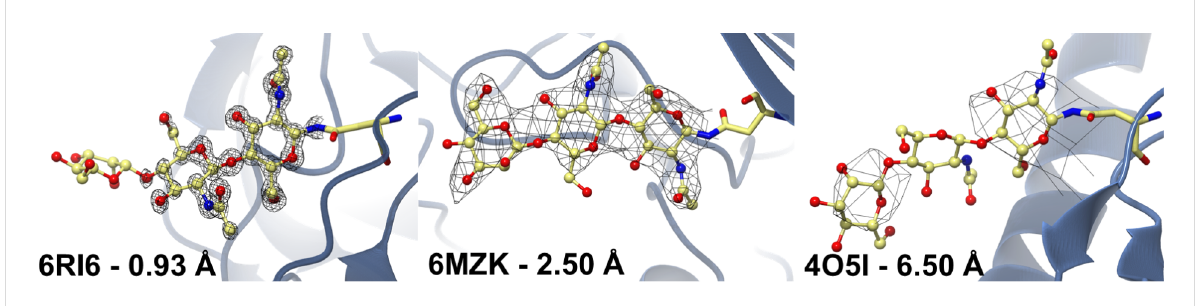
Figure 1: Comparison of the glycan features in electron density maps over a range of resolutions from selected glycoprotein structures (PDB entries: 6RI6 [19]; 6MZK [20]; 4O5I [21]). The electron density maps were obtained with X-ray crystallography. The data resolution and PDB entry IDs associ- ated with the structures have been directly annotated on the structure. Left: A high-resolution example where monosaccharides and the conforma- tions can be elucidated; middle: A medium resolution example where the identification starts to become difficult; right: A low-resolution example for which all prior knowledge must be used. Despite coming from different glycoprotein structures, the glycan has the same composition, and thus is assigned a unique GlyTouCan ID of